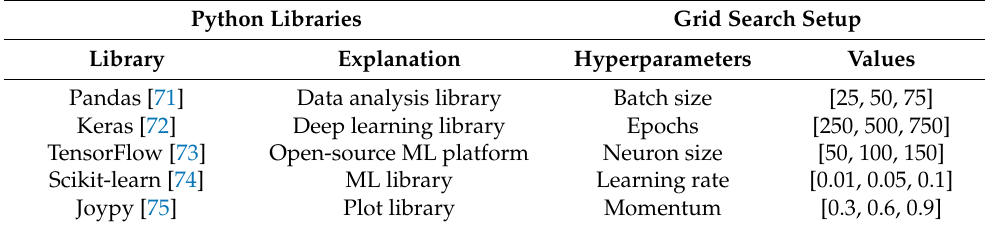
Table 7. Python libraries and grid search